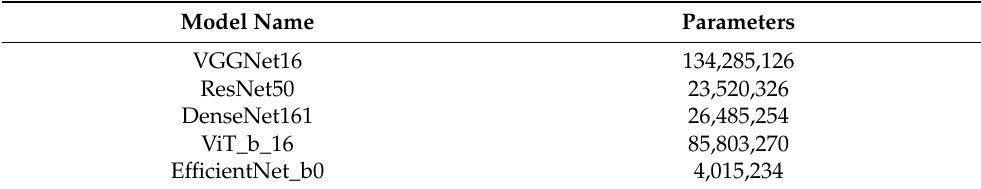
Table 1. Comparison of five model